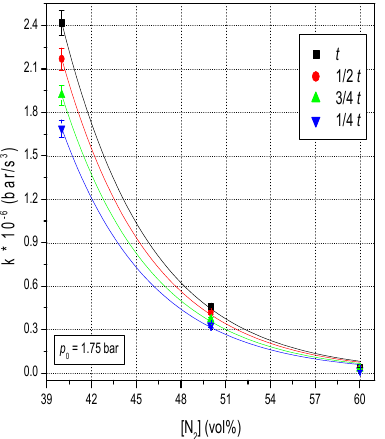
Figure 6. Variation of cubic law coefficients with diluent concentration for stoichiometric CH 4 -N 2 O mixtures, diluted with N 2 , at p 0 = 1.75 bar and ambient initial temperature.